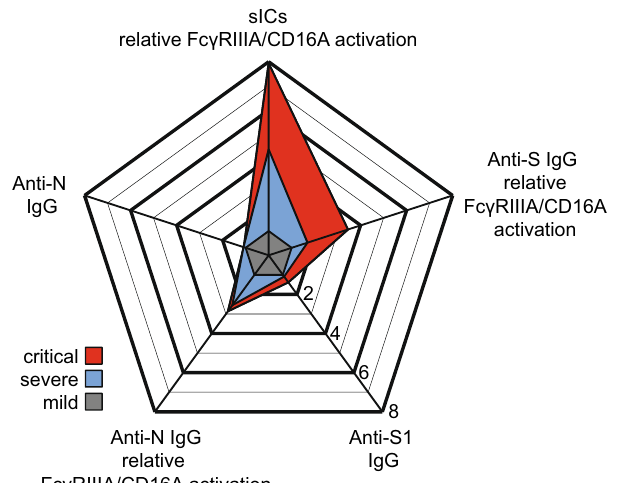
Fig. 5 | Summary ofantibody features from SARS-CoV-2-infected patients with critical and severe disease. Relative multivariate antibody features illustrated as radar chart in critically (red) or severely (blue) diseased COVID-19 patients nor- malized to the corresponding features of patients with mild infection (grey). Each spoke represents one of the following variables: ELISA (S1-IgG, N-IgG,) and CD16 activation (S-IgG, N-IgG, multimeric sICs). Arithmetic mean values of log 2 values werecalculated for eachgroup (days 13-25 postsymptom onset), respectively. The fold change compared to mildly diseased patients is shown. Source data are pro- vided as a Source Data fi